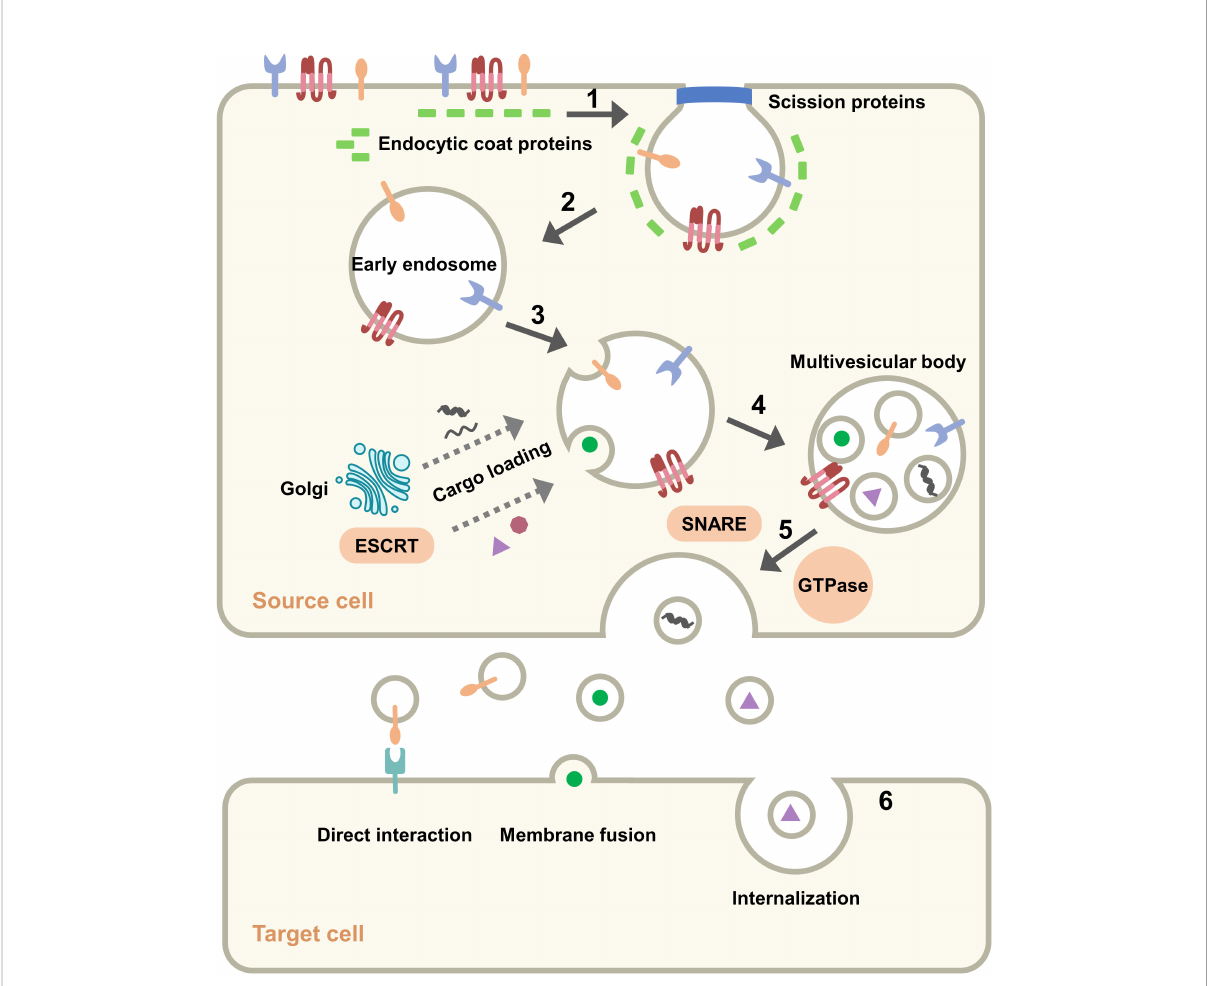
FIGURE 2 Pathway of exosomes: origin, formation, secretion and uptake. (1) Plasma membrane invagination. (2) Formation of early endosome. (3) Cargo loading and production of intraluminal vesicles. (4) Formation of multiple vesicle bodies. (5) Secretion of exosomes from the source cell to the outside. (6) Mode of exosomes with target